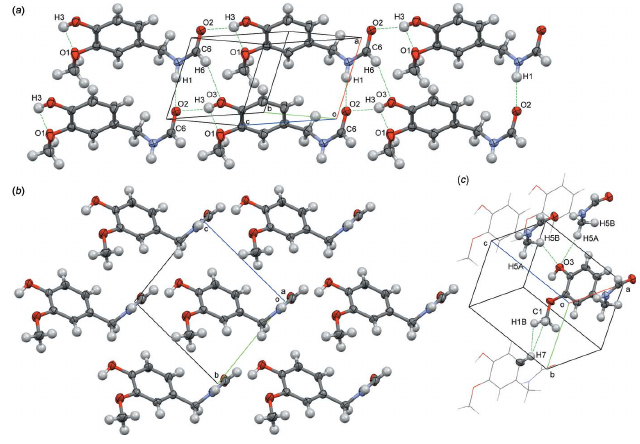
Figure 3 ( a ) Main hydrogen bonds and dipole–dipole interactions inside the polar sheets of vanillylformamide ( II ). ( b ) Stacking of the polar sheets along the a axis. ( c ) Weak interactions between the polar sheets.